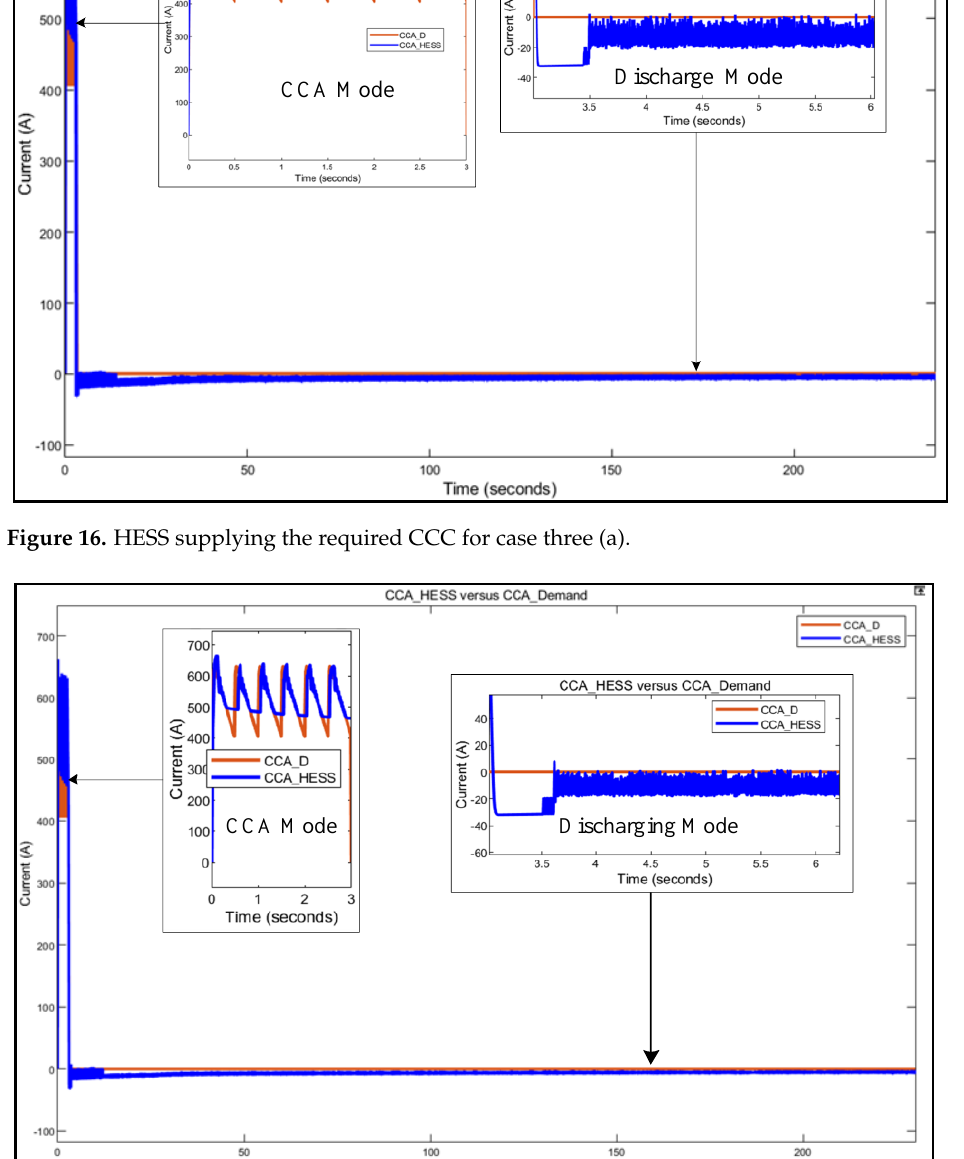
Figure 17. HESS supplying the required CCC for case three